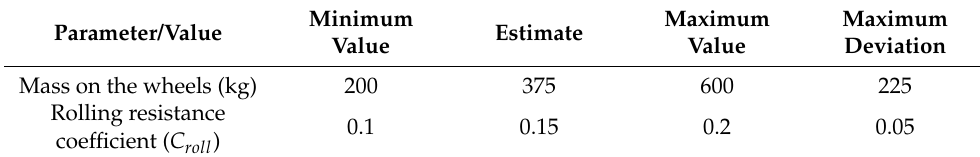
Table 3. Bounded model